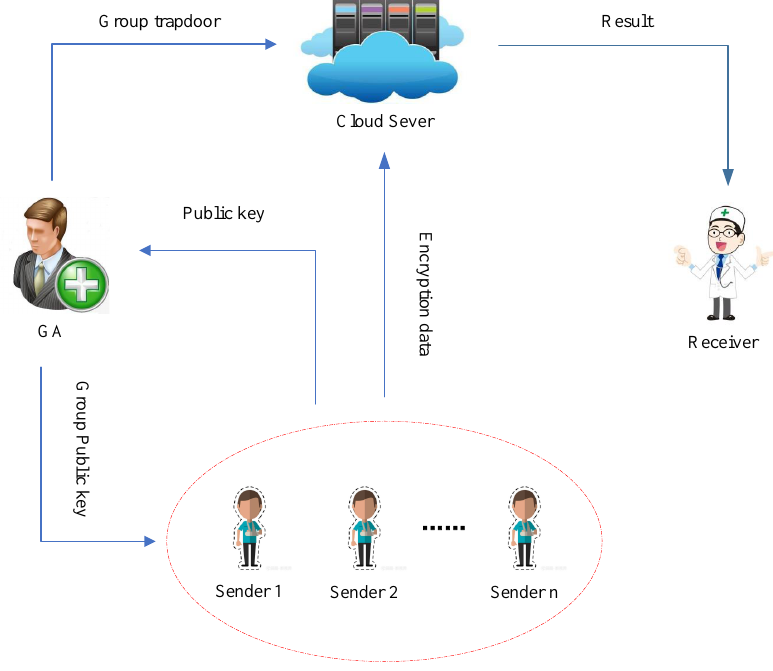
Figure 2. G-PKEET system